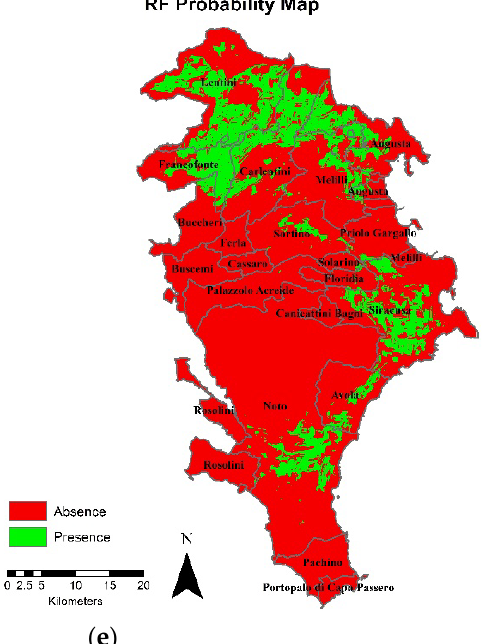
Figure 4. Probability Maps, obtained by applying the threshold for probability for each model, in the province of Syracuse: ( a ) BRT; ( b ) GLM; ( c ) MARS; ( d ) MaxEnt; and ( e ) RF.